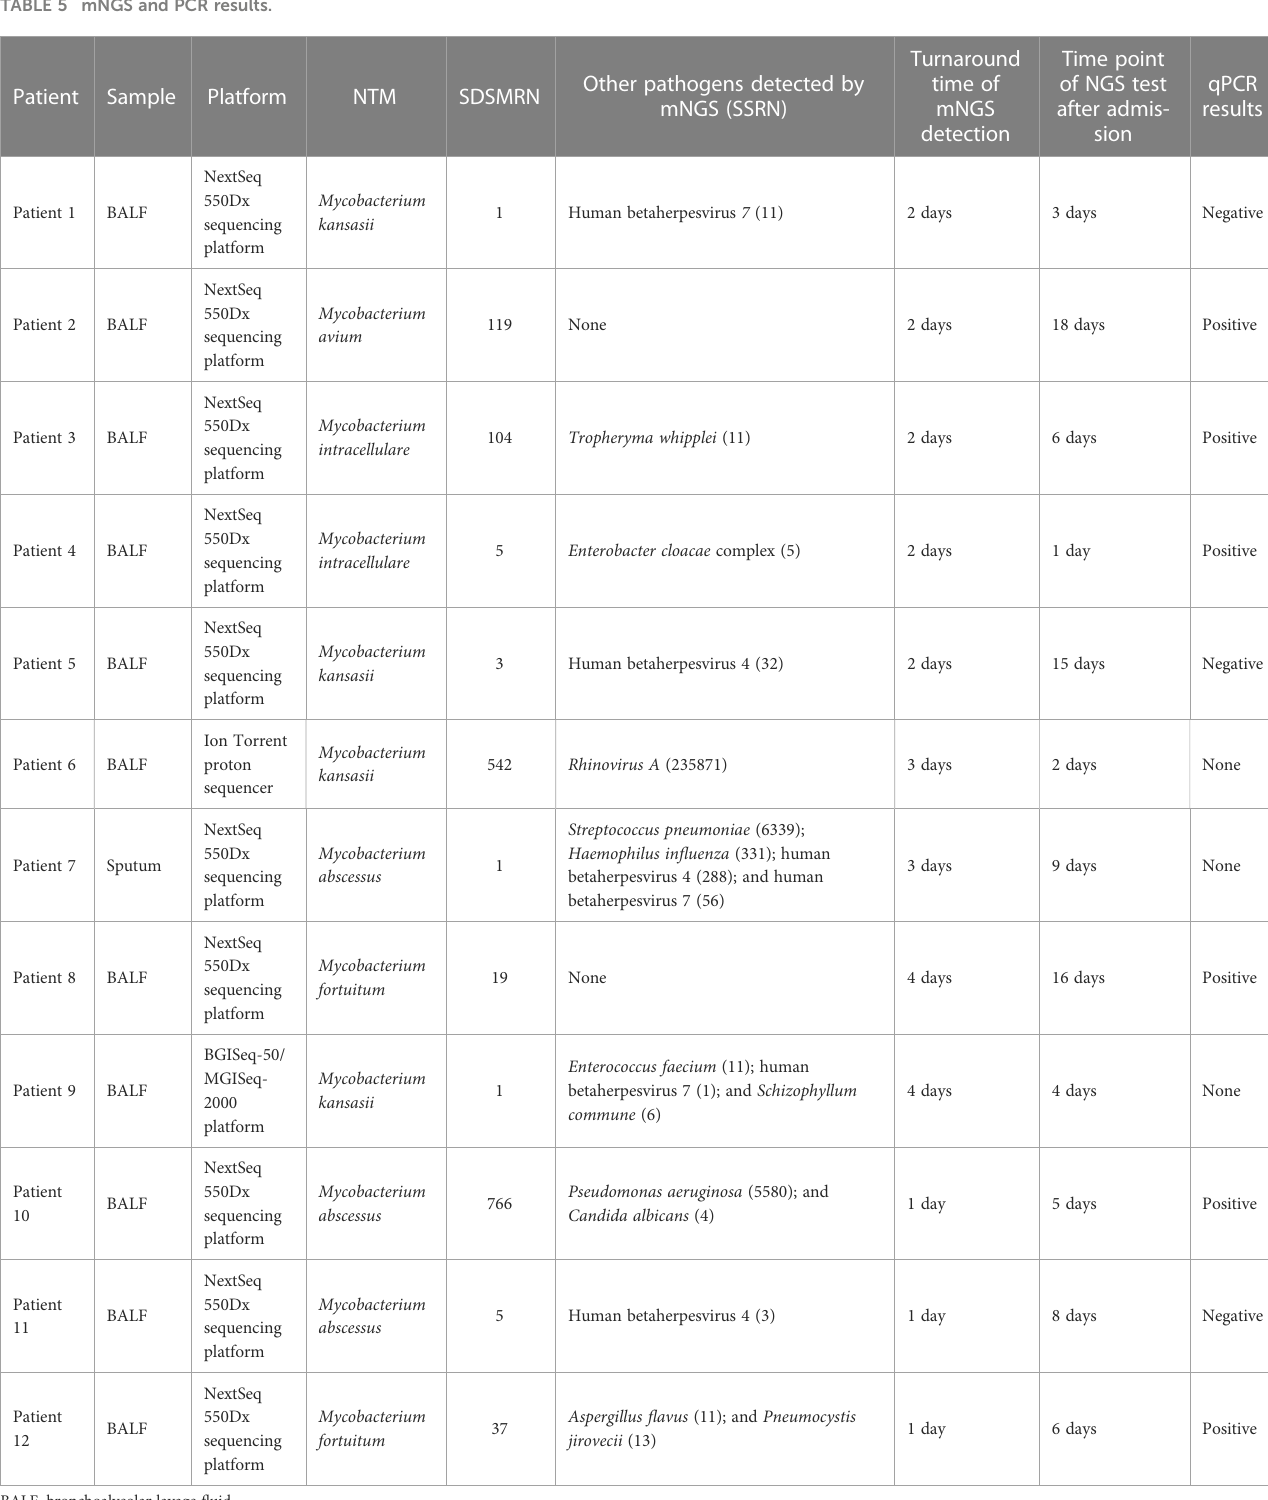
TABLE 5 mNGS and PCR